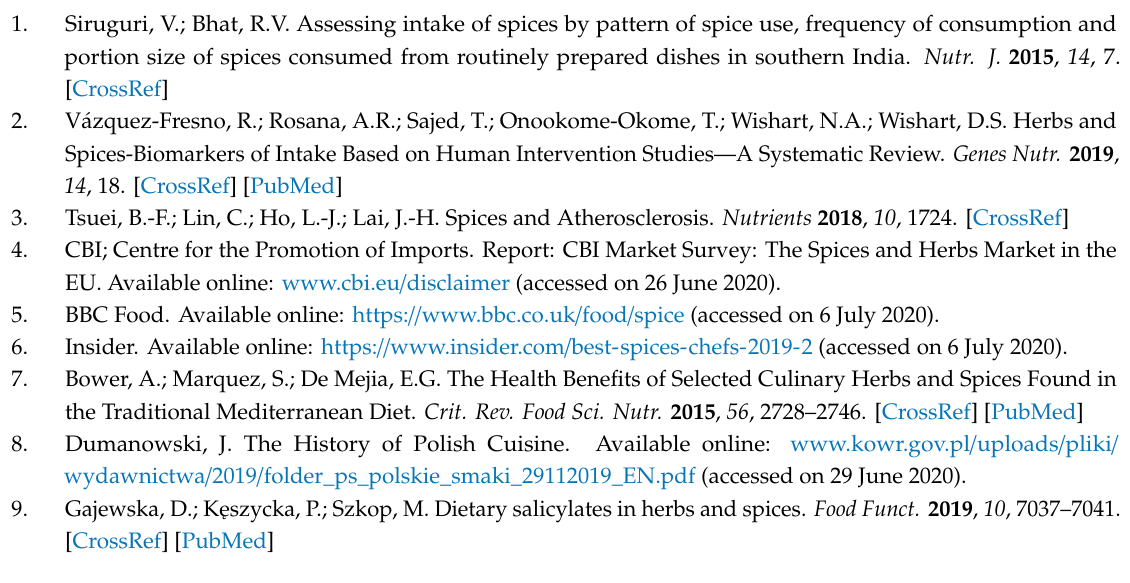
Figure S1: The contribution of individual herbs and spices to the total dietary salicylates intake among adult omnivores and vegans, Table S1: Herbs and spices typical for vegan and mixed dishes. Author Contributions: Conceptualization, D.G. and P.K.K.; methodology, D.G. and P.K.K.; software,